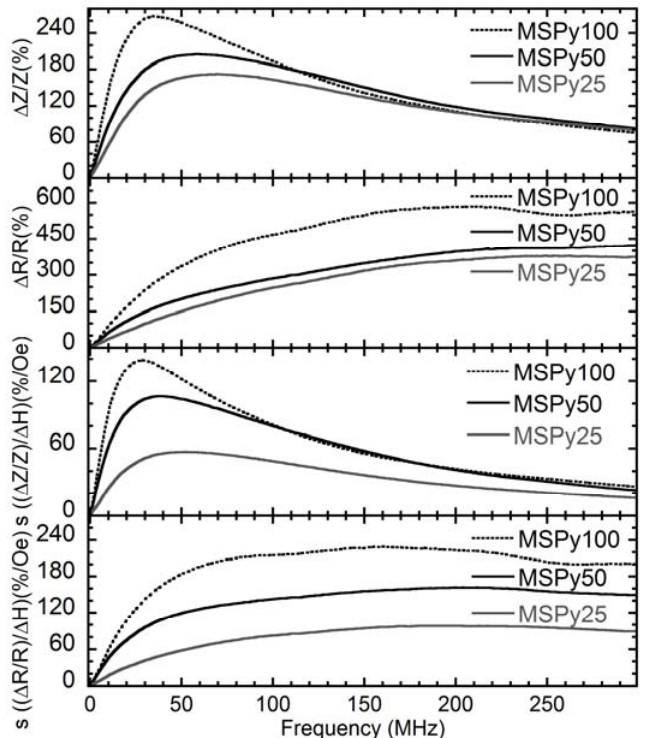
Figure 6. Frequency dependence of the maximum value of the ∆ Z / Z ratio, maximum value of the ∆ R / R ratio, maximum value of the sensitivity s [( ∆ Z / Z )/ ∆ H ] and maximum value of the sensitivity of the real part of the impedance s [( ∆ R / R )/ ∆ H ] for the three multilayer sandwiched